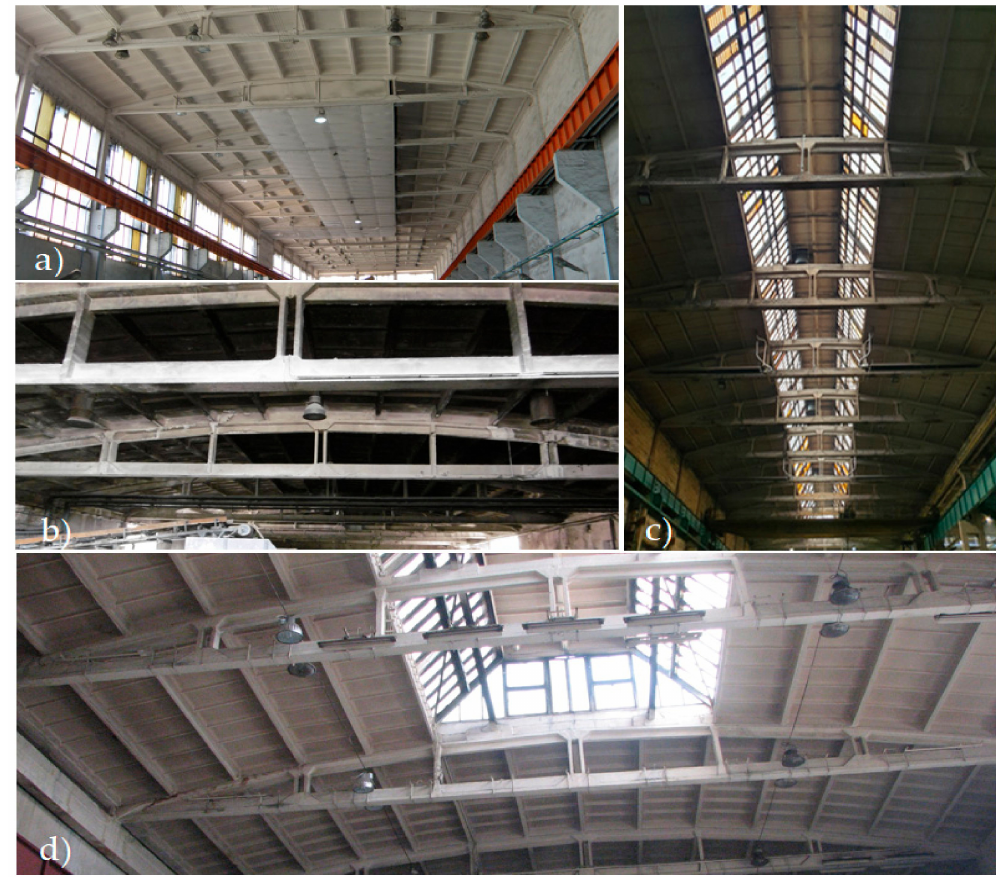
Figure 2. Factory buildings with a large number of cable post-tensioned concrete girders: ( a ) production and assembly hall; ( b , c ) production hall; ( d ) storage hall for powdered